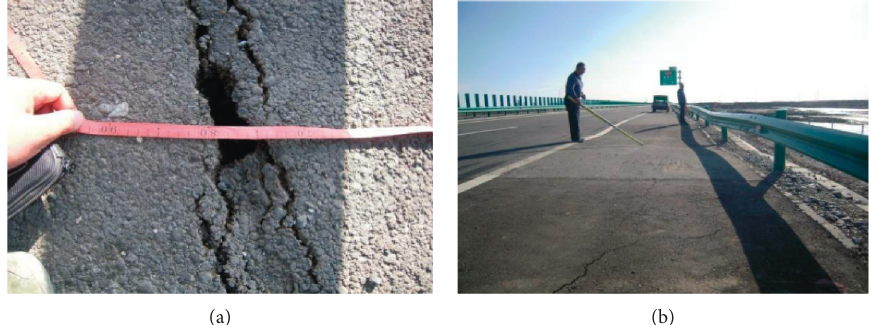
Figure 1: Saline soil-induced pavement cracking and